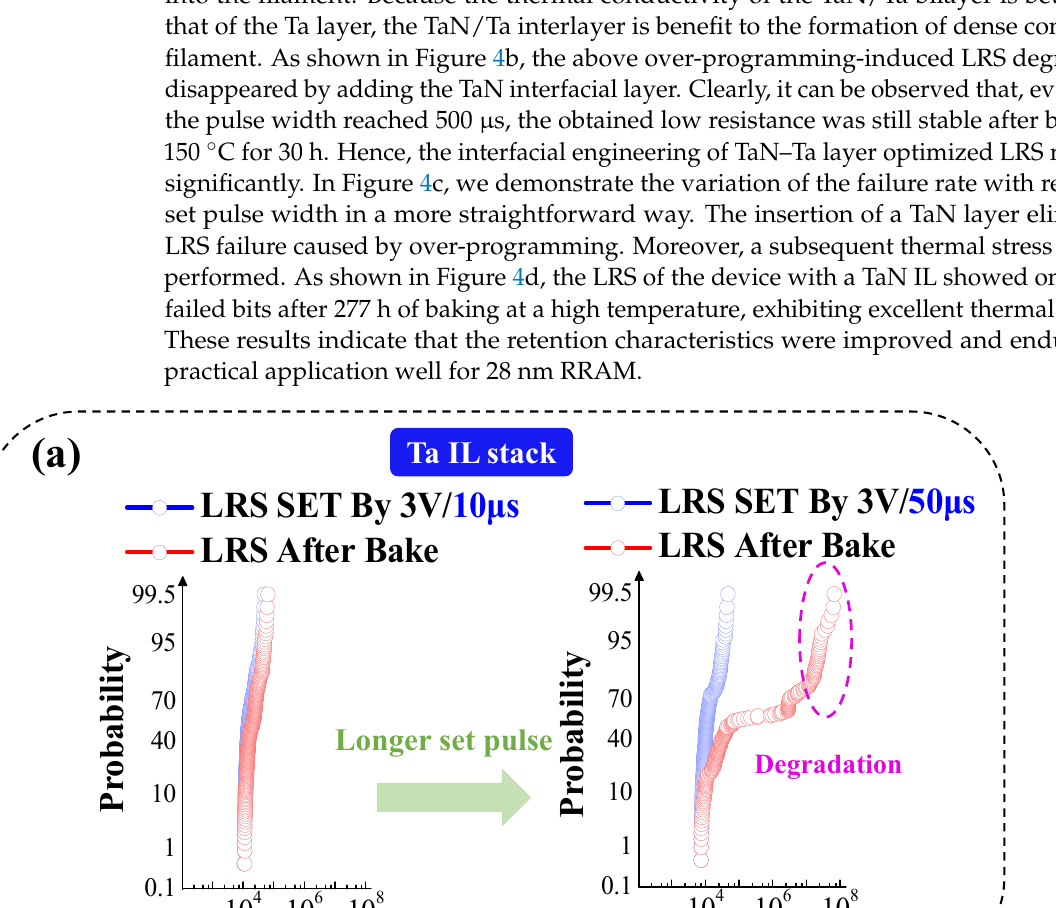
Figure 4. The LRS retention obtained under both a short set pulse and a long set pulse for ( a ) the Ta- IL-stack RRAM and ( b ) the TaN-Ta-IL-stack RRAM. ( c ) The trends of LRS failure rate variations at different set pulse widths. ( d ) LRS retention measurement of the TaN-Ta-IL-stack at 150 °C for 277 h with the forming pulse of 500 μ s. 4. Conclusions In this paper, the thermal stability of pre-programmed RRAM was investigated sys- tematically based on a 1T1R memory array fabricated on a 28 nm platform. To improve the capability of enduring reflow, a TaN interfacial layer was introduced. The adoption of TaN interfacial layer not only redistributed oxygen vacancies in the conductive filament, but also improved the electromigration lifetimes of Cu-based damascene interconnects, which was beneficial for improving the thermal stability of RRAM. Additionally, we